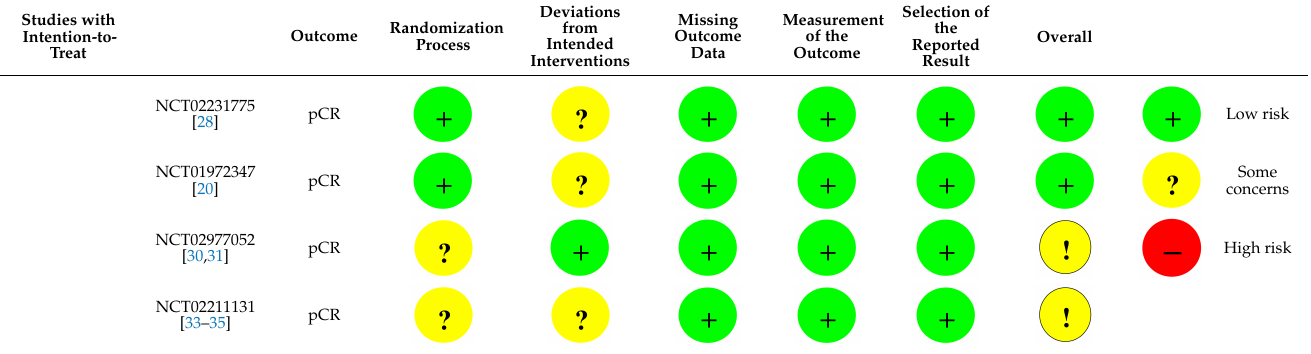
Table A1. Risk of bias summary for the randomized controlled trials using the cochrane risk of bias tool. Studies with Intention-to-